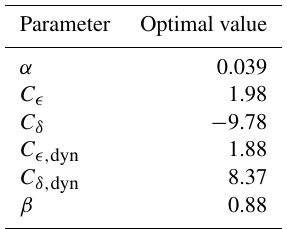
Table A1. Optimal value of the input parameters of the PRMv2